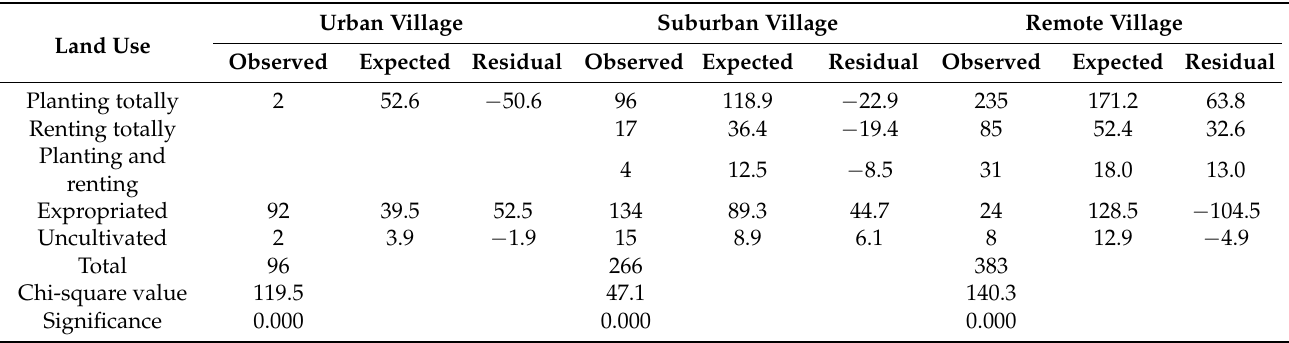
Table 5. Non-parametric chi-square test of offspring support in rural Table 5. Non ‐ parametric chi ‐ square test of offspring support in rural villages.